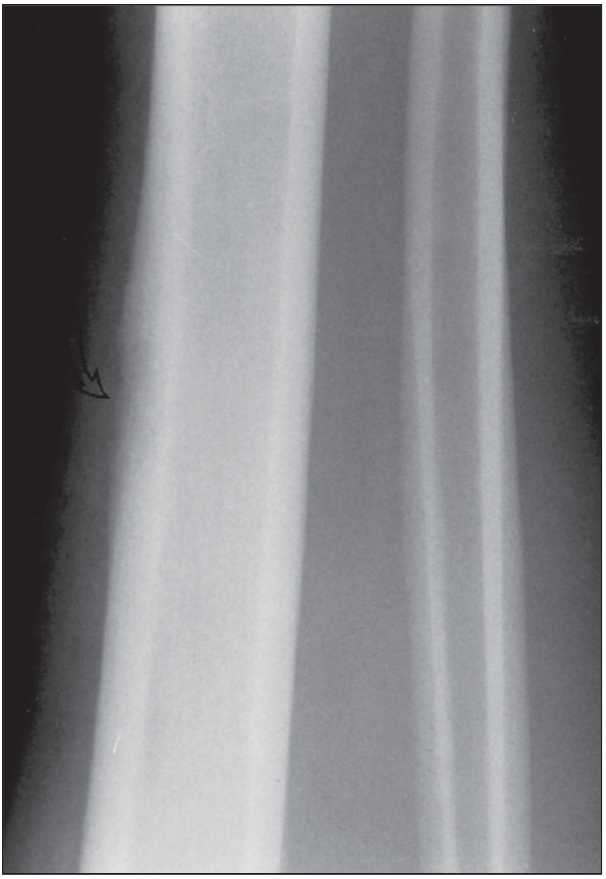
Figure 2) Following four weeks of antibiotic therapy, only residual signs of the infection were seen on the radiograph of the left tibia (ar-